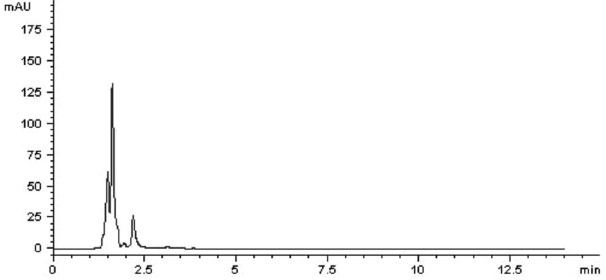
FIGURE 2A - Representative chromatogram of blank plasma.